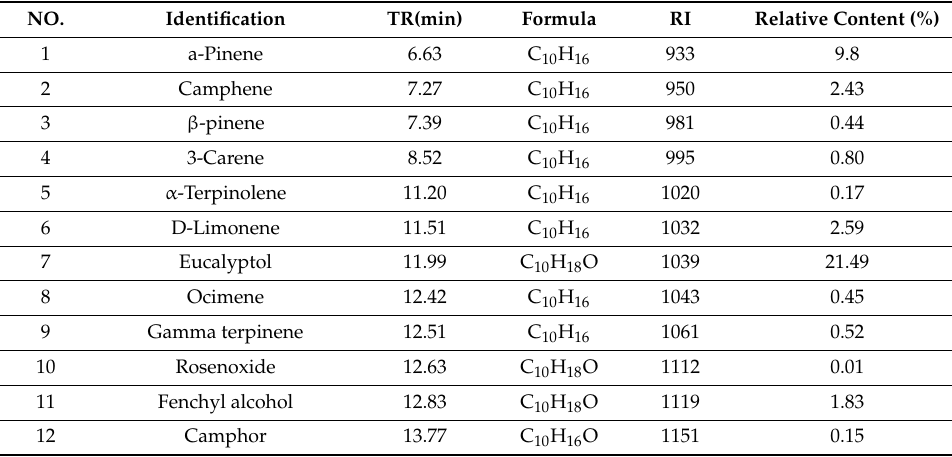
Table 2. Analysis of volatile components of E. globulus leaves by